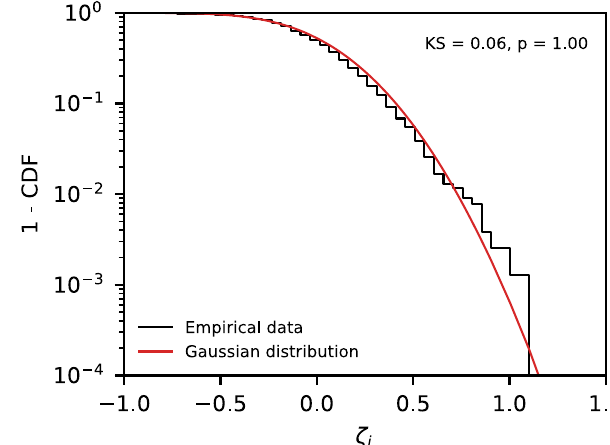
Fig. 6 | Extreme shocks are dissipatedat the countylevel. The distribution of ζ i , which is the sum of the net fl ows of a county i adjusted by its population, suggests thatmigratoryevents are exponentiallybounded atthe county levelsince ζ i iswell described byaGaussiandistribution.The distributionof ζ i iscomputedhereforall the counties with at least 50.000 inhabitants. We also show the result of the two- sided KS test under the null hypothesis that ζ i follows a Gaussian distribution.